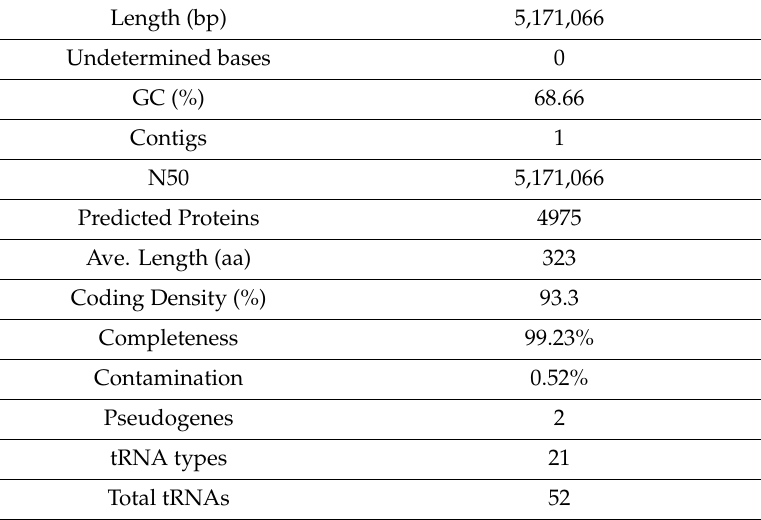
Table 1. Characteristics of the genome of Nocardioides sp. WS12.